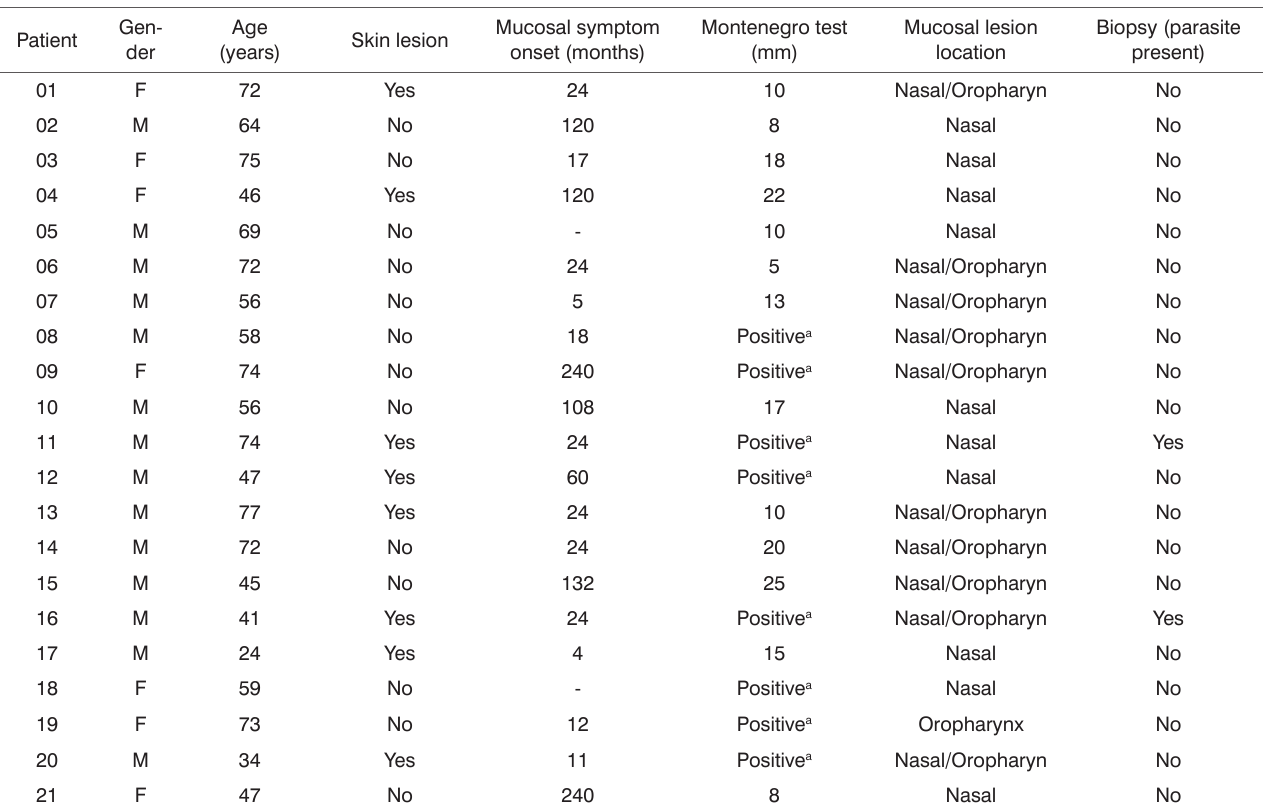
Table 1. Patients with recent diagnosis of mucosal leishmaniasis seen in the Otorhinolaryngology clinic of our University Hospital, between April of 2008 and April of 2009.